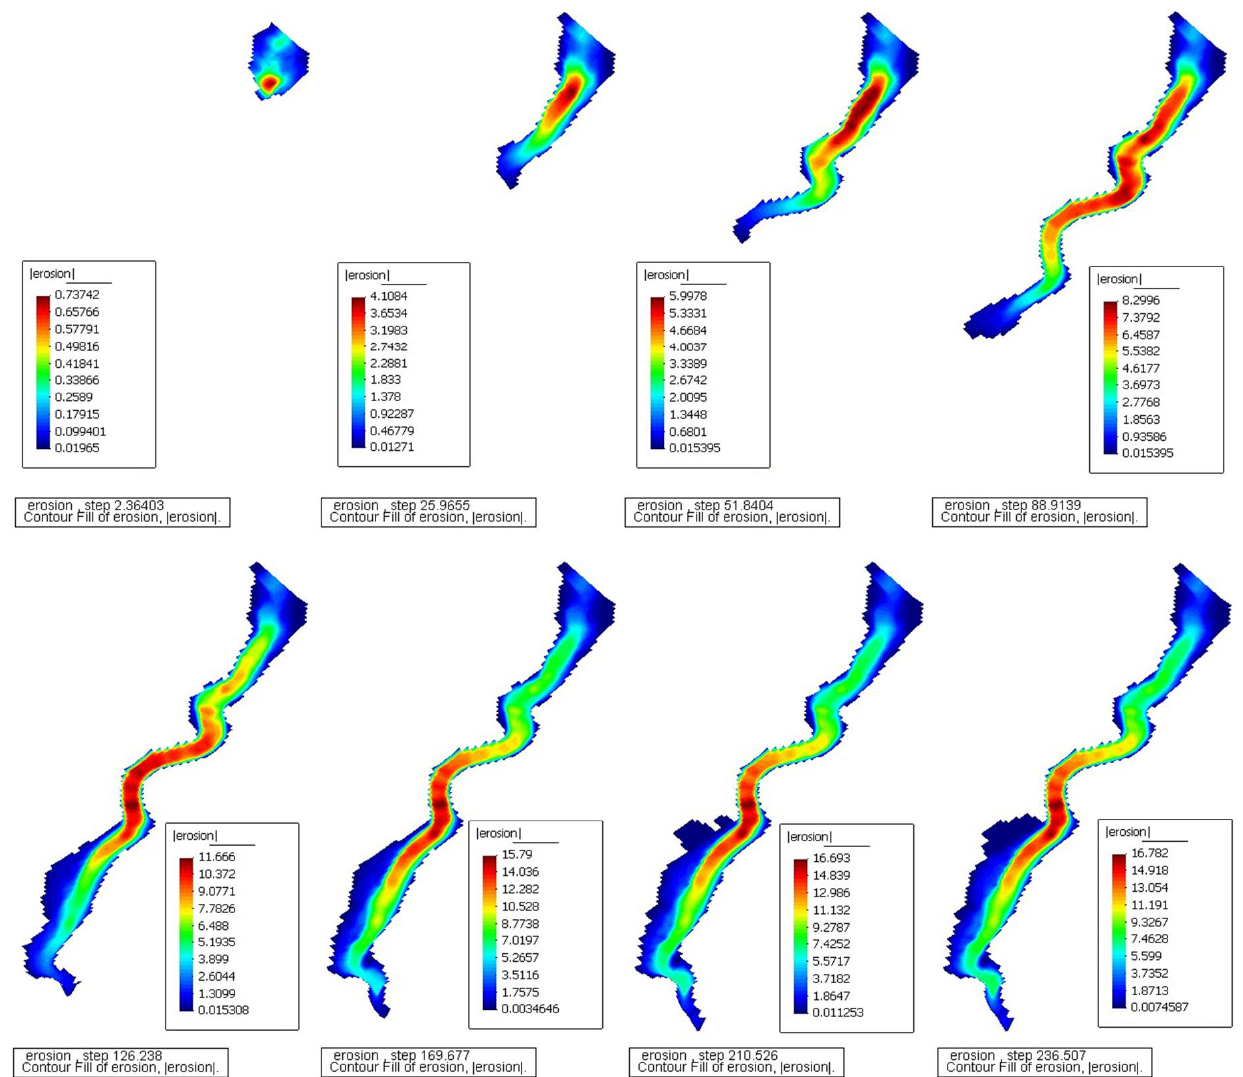
Figure 13. The simulation view of erosion activity on the Rjeˇcina watercourse with the application of the Egashira erosion law, Simulation